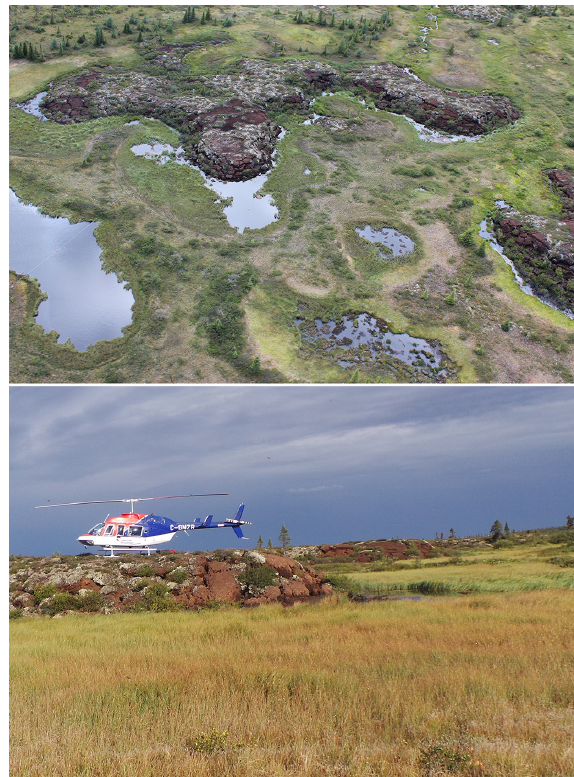
Figure 2. Palsas and their associated thermokarst lakes in the SAS valley. Upper panel: aerial view of the SAS1 area; lower panel ground-level view of SAS1B (photograph by Alexander